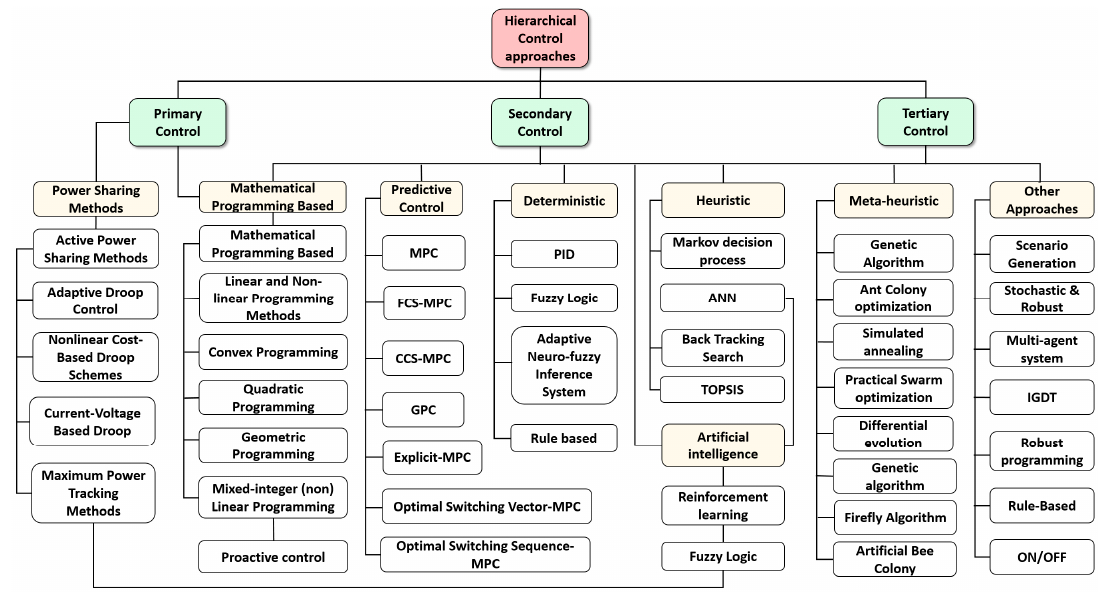
Figure 7. Control approaches for energy management systems.